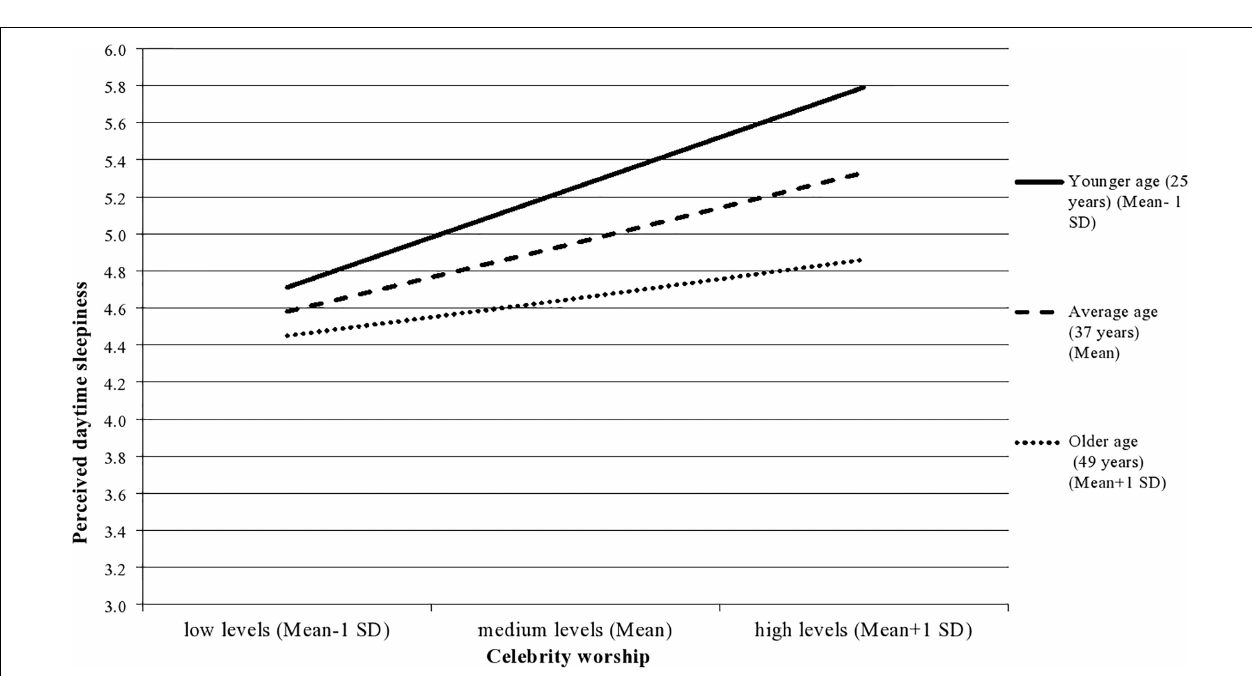
FIGURE 2 | The moderating role of age on the association between celebrity worship and perceived